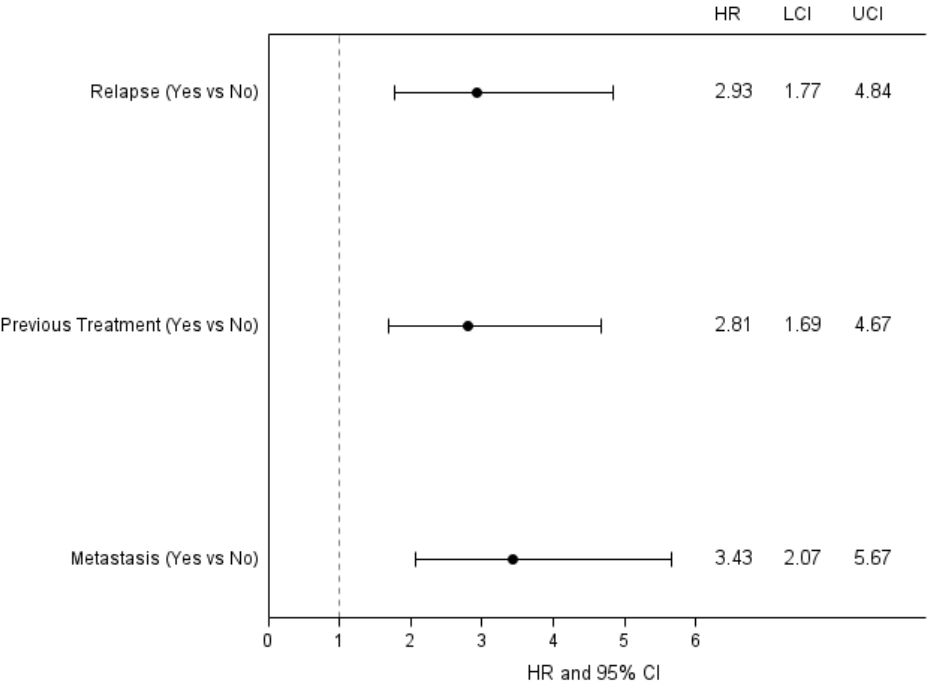
Table 8. Results from univariate Logistic models for Complication.